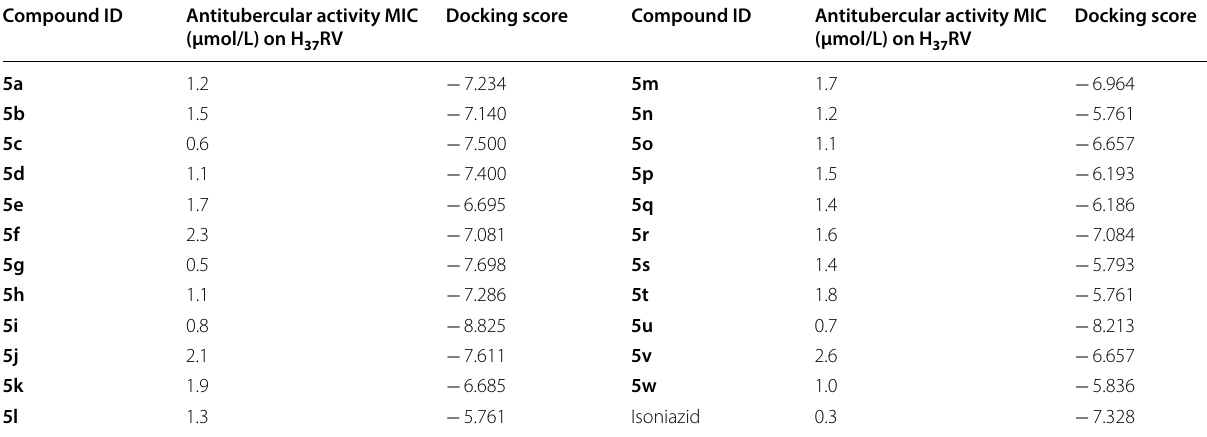
Rv) and docking score of synthesized 37